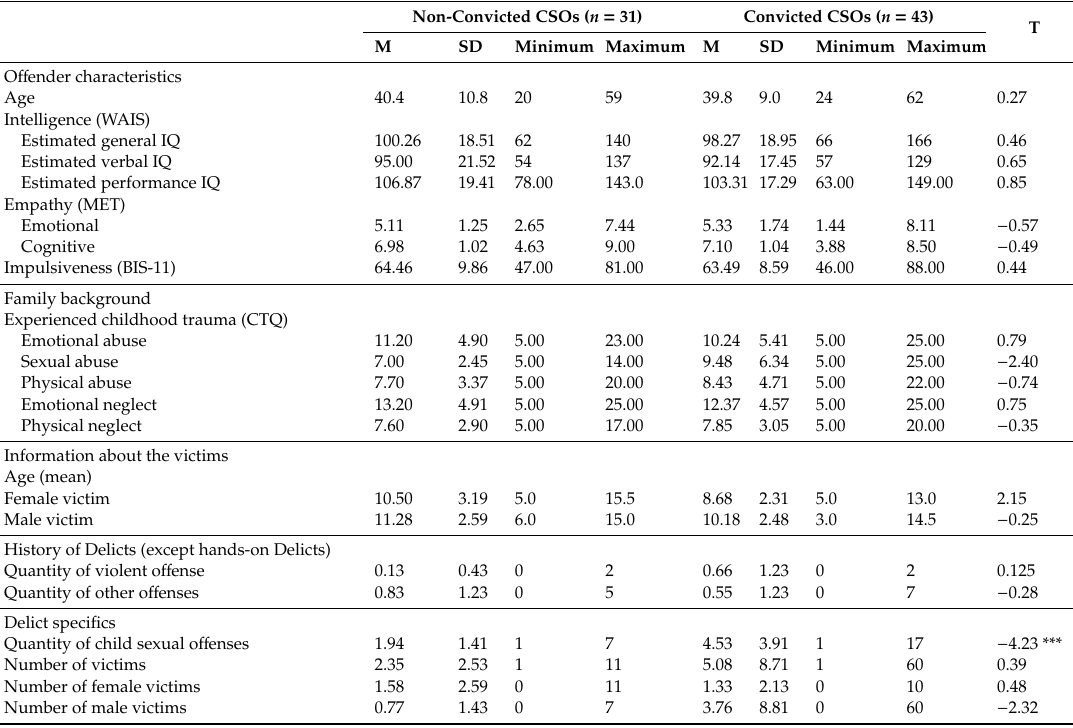
Table 1. Characteristics of non-convicted and convicted child sexual o ff enders